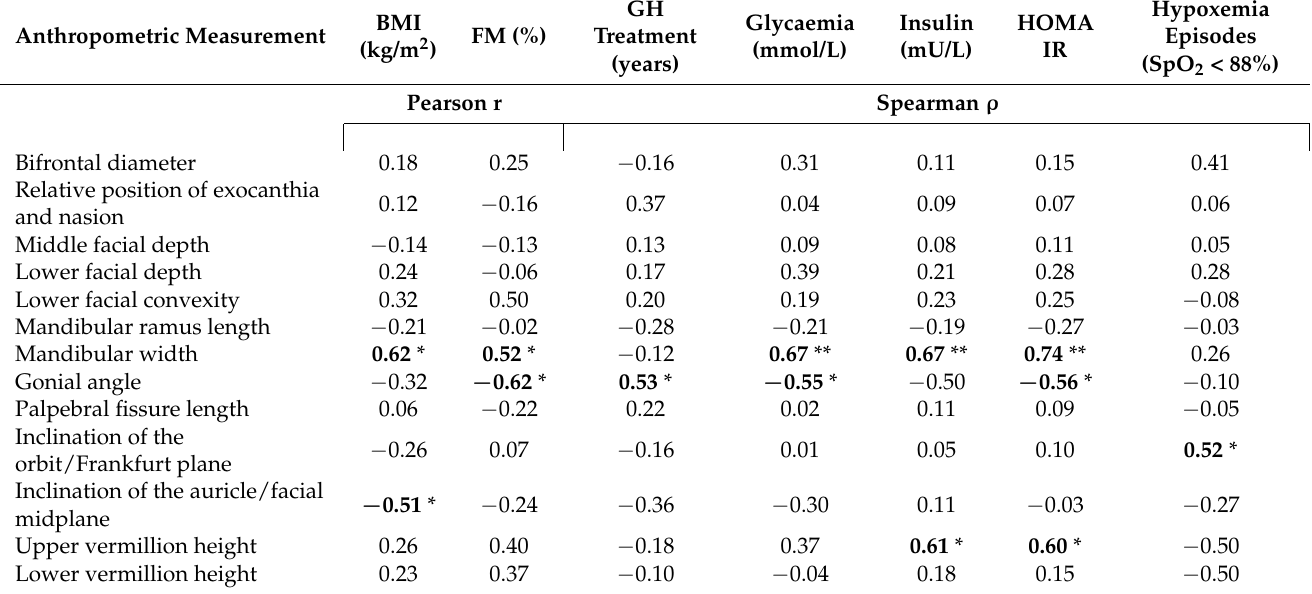
Table 4. Correlation between facial anthropometric measurements with mean z-scores of at least |1| and other clinical features in patients with